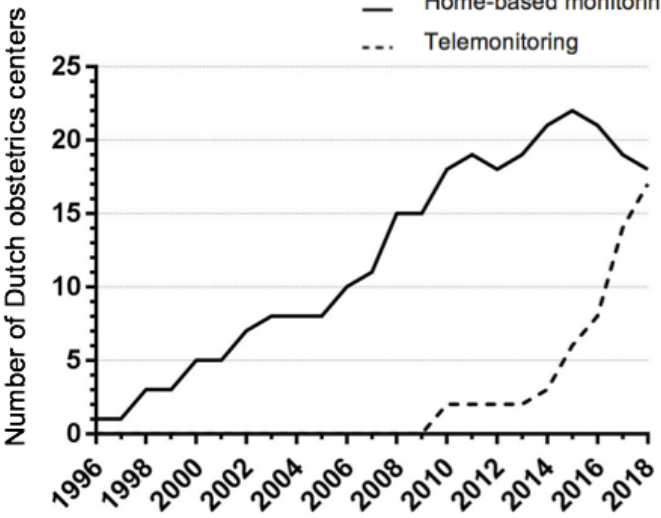
Figure 3. Trend graph of obstetrics departments offering home-based monitoring and telemonitoring for high-risk pregnancies in the